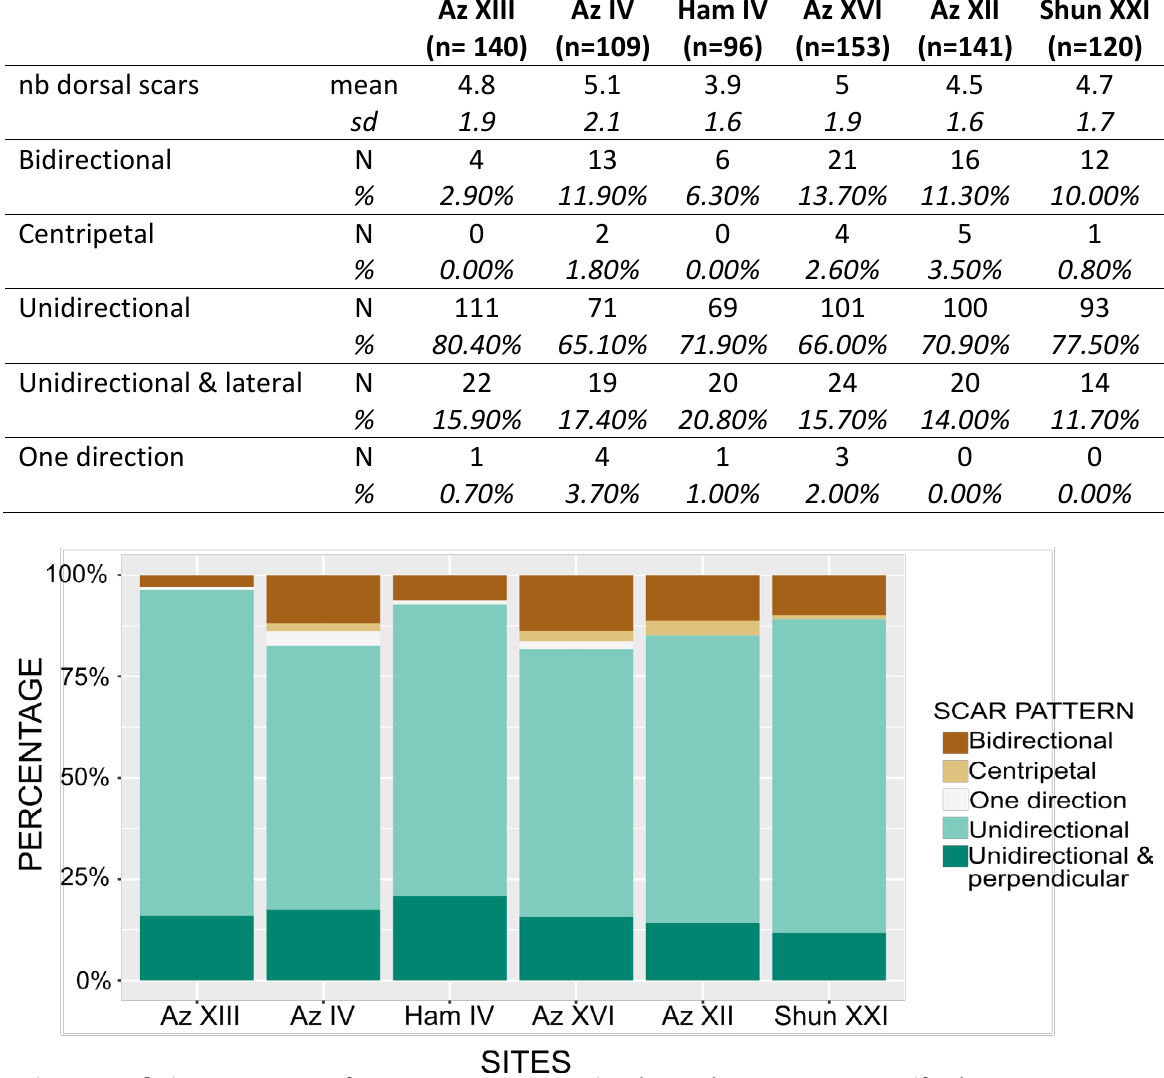
Table 8. Number of dorsal scars and types of scar pattern of the elongated blanks. In bold: values with the highest (positive or negative) residuals of the Chi2 test (<1.2 or >1.2). Az - Azariq; Shun - Shunera; Ham - Hamifgash.